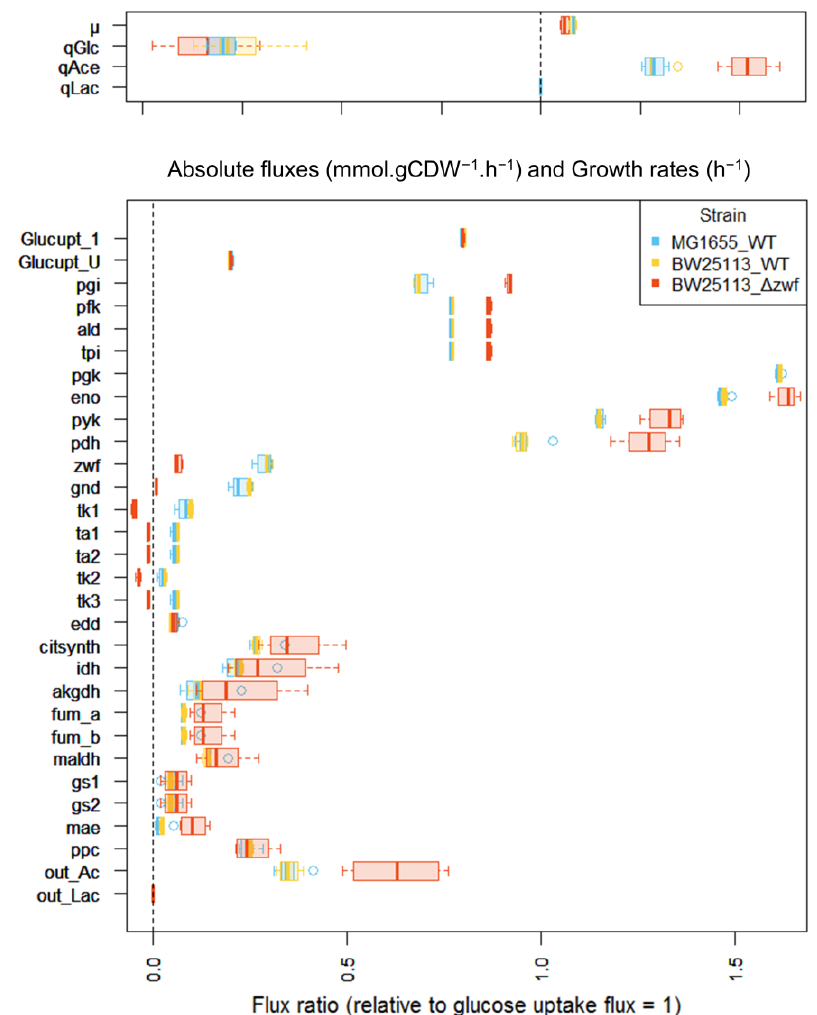
Figure 2. Metabolic fluxes measured for E. coli WT strains and a ∆ zwf mutant strain. Top: experimentally measured fluxes (expressed in mmol.gDW −1 ·h −1 ) and growth rate (expressed in h −1 ). Physiological measurements: µ , growth rate; qGlc, glucose specific consumption rate; qAce, acetate specific production rate; qLac, lactate specific production rate. Bottom: Intracellular fluxes calculated from the 13 C-labelling data; fluxes are expressed relative to the glucose uptake rate set arbitrarily to 1 for each strain. Boxplot produced with the software R representing median fluxes (bold line) in boxes representing the interquartile range (quartile 1–quartile 3). The whiskers extend to the most extreme data point that is no more than 1.5 times the interquartile range from the box. Net fluxes: Glucupt_1 and Glucupt_U: [1- 13 C]-glucose and [1- 13 C]-glucose importation (PTS system), pgi: glucose-6-phosphate isomerase, pfk: phosphofructokinase, ald: fructose-bisphosphate aldolase, tpi: triose-phosphate isomerase, pgk: phosphoglycerate kinase, eno: enolase, pyk: pyruvate kinase,